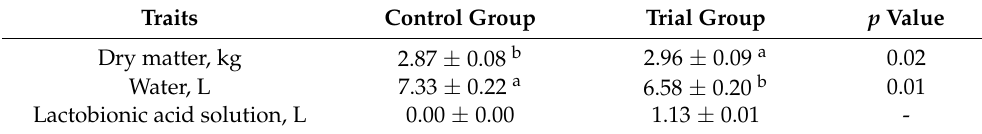
Table 3. Average daily feed intake per pig.